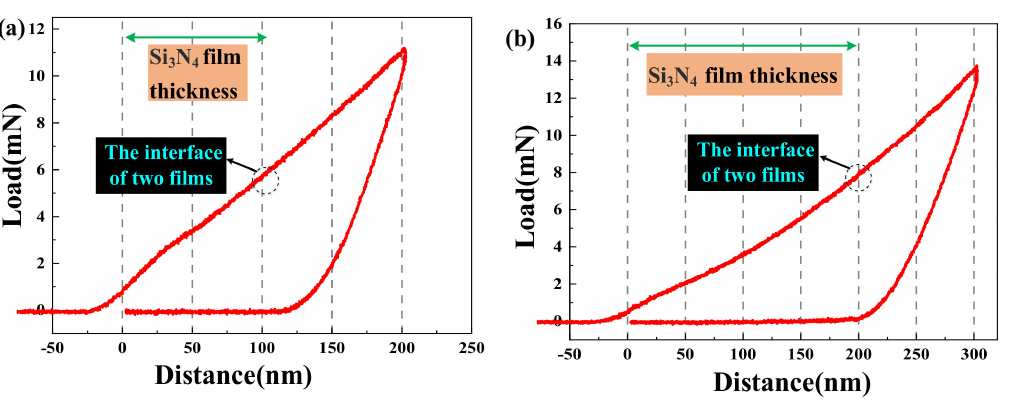
Figure 9. Load displacement curves of two different maximum indentations of TiN/Si 3 N 4 films: ( a ) 203 nm, ( b ) 302 nm. For the purpose of the study, the silicon nitride film thickness of samples 1–3 were 100 nm, the titanium nitride film thicknesses were 800 nm, 600 nm, and 400 nm, and